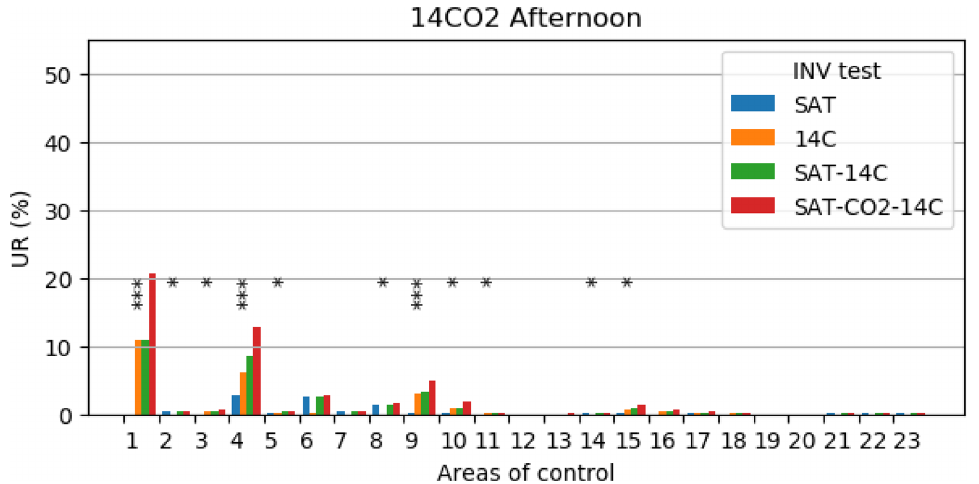
Figure A6. Uncertainty reduction in INV-SAT, INV-14C, INV-SAT-14C, and INV-SAT-CO2-14C inversions for afternoon budgets of FF emissions of each controlled area in the main area of interest. The number of stars indicates the number of stations in each controlled area. The names of the controlled areas are listed in Table